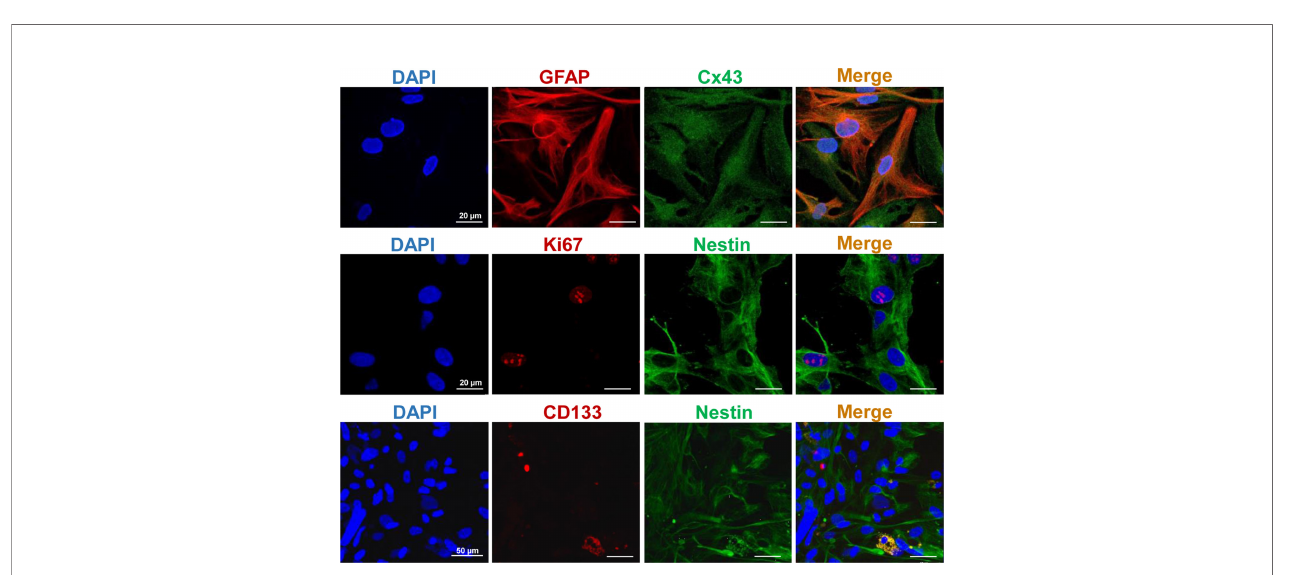
FIGURE 2 | Representative IF staining images of the primary human GBM cells. Cell nuclei were counterstained with DAPI. Bars are applicable to all images in the row.